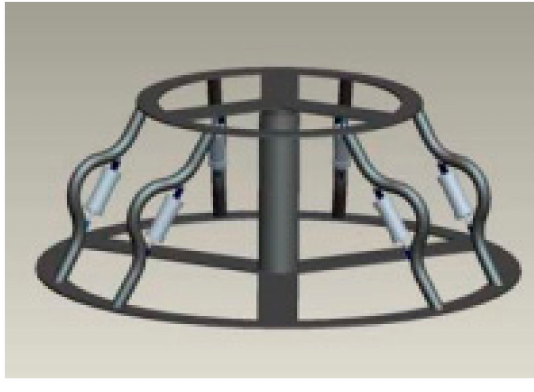
Figure 4. Parallel damping system